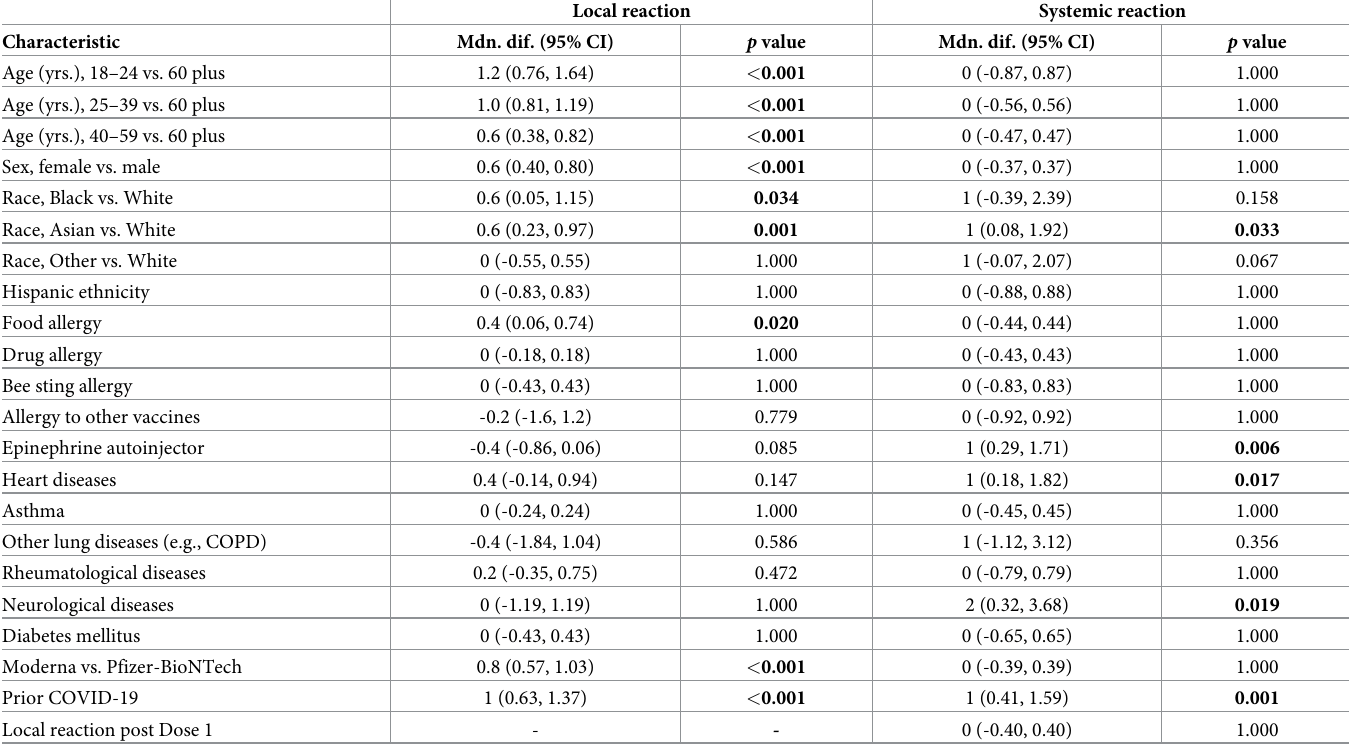
Table 4. Factors associated with the severity of local and systemic reactions following the first vaccine dose.